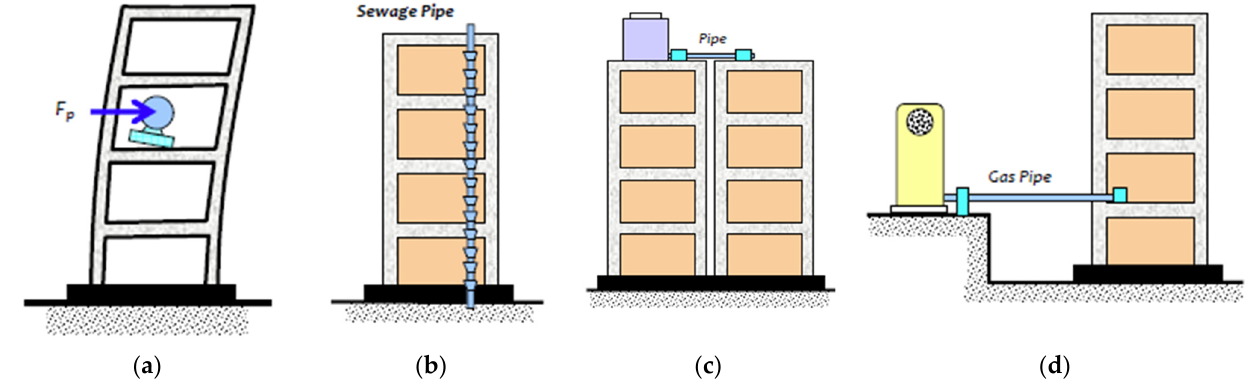
Figure 3. Effects of seismic motion on NEs: ( a ) inertial, ( b ) imposed deformations by building, ( c ) building separations, and ( d ) elements outside connected to the inside of the building [81].